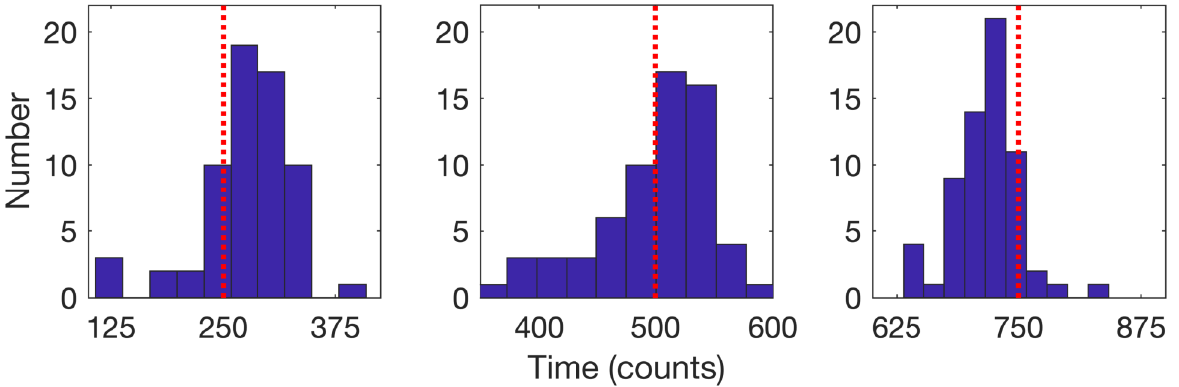
Figure 12. Histograms of the detected times of model changes when three changes were detected (64 trajectories) for the ( left ) first, ( center ) second, and ( right ) third change. Red dotted lines indicate the true change times of 250, 500, and 750. Mean detected times are 276.2 for the first, 497.1 for the second, and 717 for the